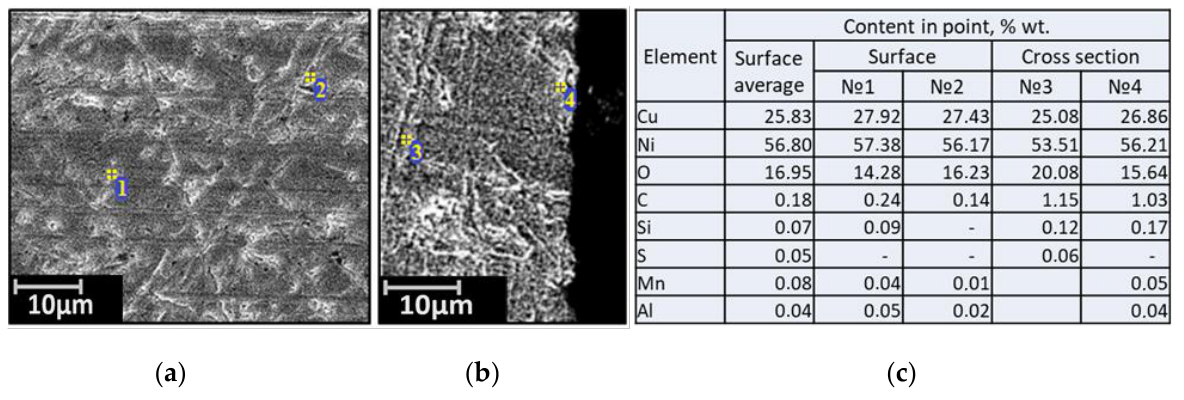
Figure 3. Micrographs of the surface ( a ), the cross-section ( b ), and the elemental composition ( c ) of the source material Monel 404.